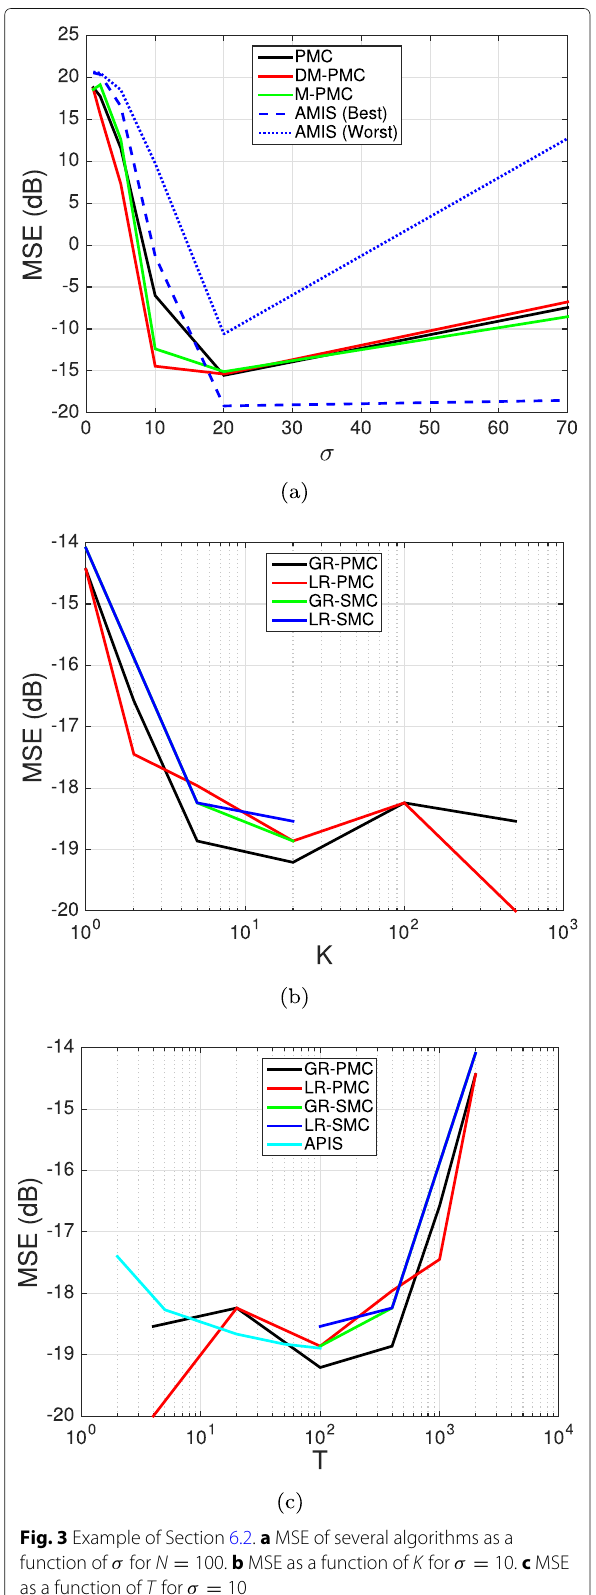
Fig. 3 Example of Section 6.2. a MSE of several algorithms as a function of σ for N = 100. b MSE as a function of K for σ = 10. c MSE as a function of T for σ =